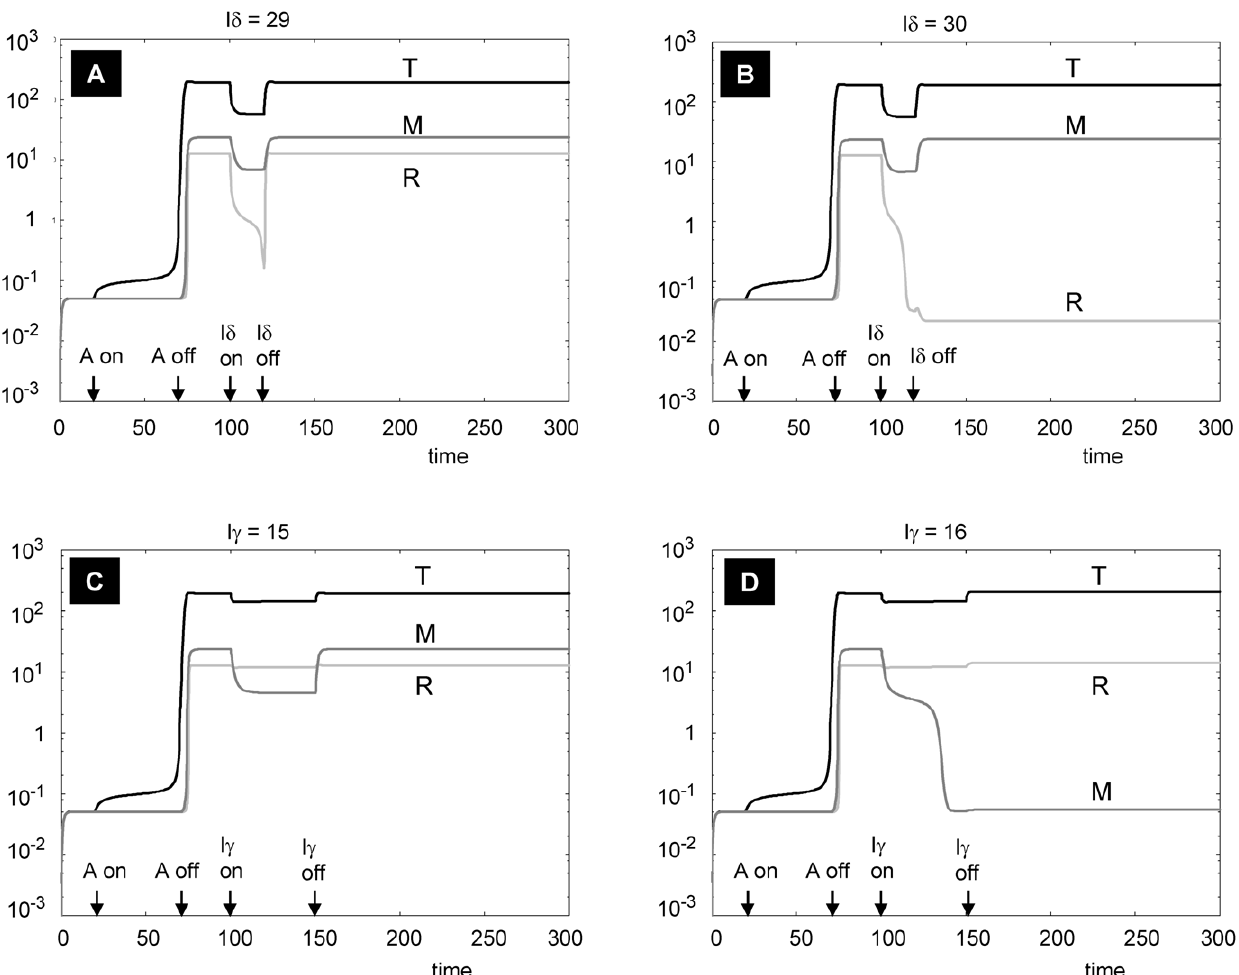
Figure 5. Single therapies using anti-IL2 (I d ) or anti-IFNg (I c ). The system is first allowed to reach low steady states of all variables, and then exposed to a square pulse of antigen (with amplitude A=100) from t=20 to t=70 to obtain a sarcoid state. As shown in (A) and (B), the model predicts that there is a threshold of anti-IL2 (between amplitudes I d =29 and I d = 30) that will push the steady state of R to a low level, but not T and M. The anti-IL2 therapy is represented by asquare pulse of Id given between t=100 and t=120. And as shown in (C) and (D), the model also predicts that there is a threshold of anti-IFN c (between amplitudes I c =15 and I c =16) that will push the steady state of M to a low level, but not T and R. The anti-IFN c therapy is represented by a square pulse of I c given between t=100 and t=150. All parameters as in Table 2, except k 2a